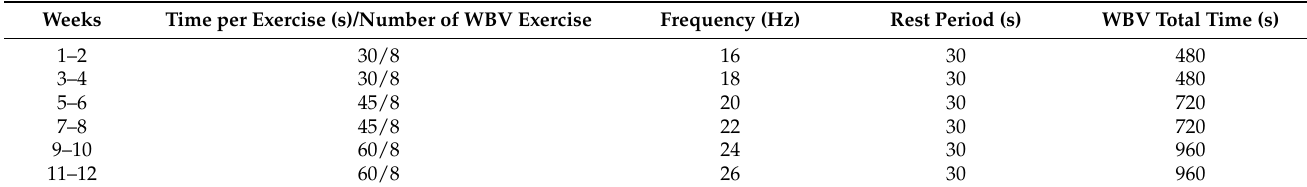
Table 2. Description of the whole-body vibration (WBV) protocol over 12